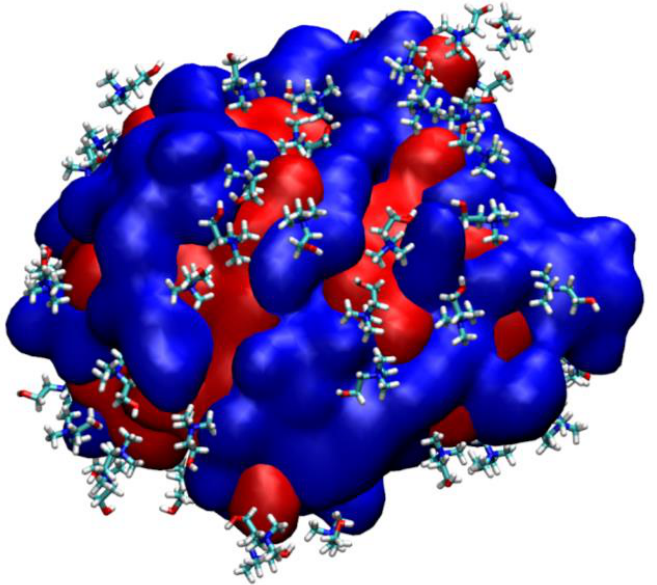
Figure 9. The interaction of cholinium cations with hydrophobic surface of PETase. The hydrophobic surface is colored in red and the hydrophilic surface is colored in blue.